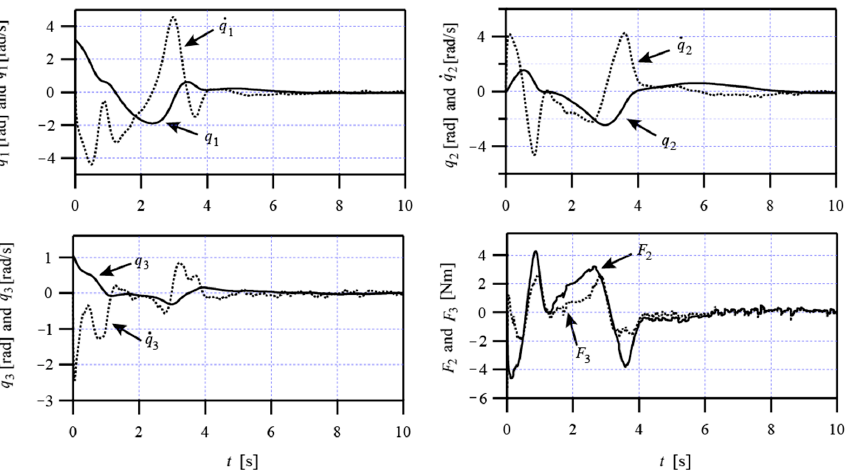
Figure 3. Simulation results for the control system (1) and (7).